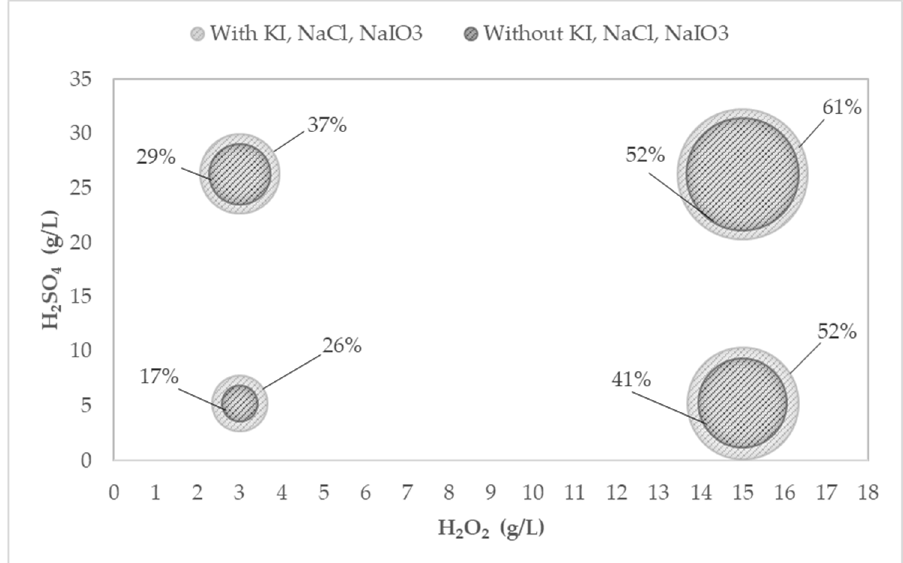
Figure 5. Representation of the effects of reagents as a function of hydrogen peroxide and acid concentrations during copper extraction.